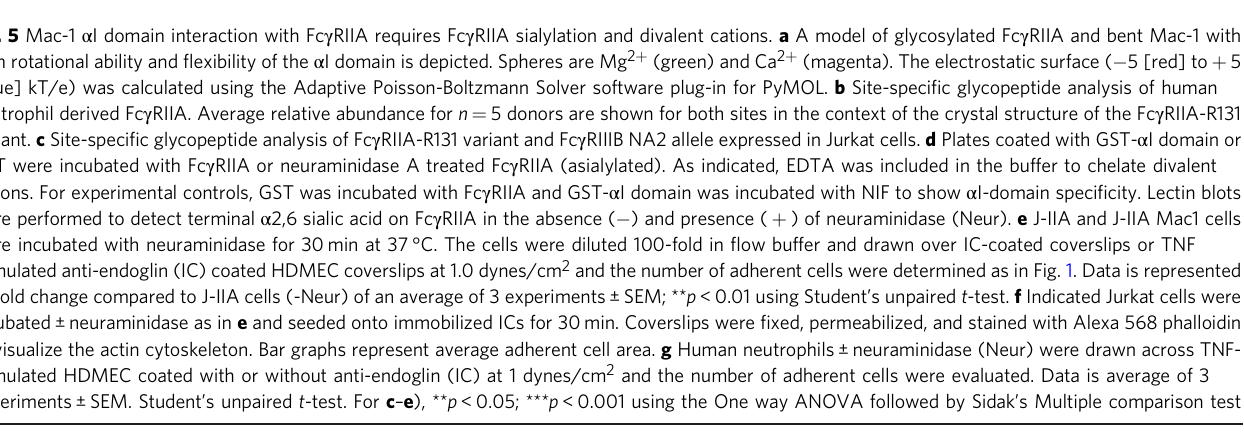
Fig. 5 Mac-1 α I domain interaction with Fc γ RIIA requires Fc γ RIIA sialylation and divalent cations. a A model of glycosylated Fc γ RIIA and bent Mac-1 with high rotational ability and fl exibility of the α I domain is depicted. Spheres are Mg 2 + (green) and Ca 2 + (magenta). The electrostatic surface ( − 5 [red] to + 5 [blue] kT/e) was calculated using the Adaptive Poisson-Boltzmann Solver software plug-in for PyMOL. b Site-speci fi c glycopeptide analysis of human neutrophil derived Fc γ RIIA. Average relative abundance for n = 5 donors are shown for both sites in the context of the crystal structure of the Fc γ RIIA-R131 variant. c Site-speci fi c glycopeptide analysis of Fc γ RIIA-R131 variant and Fc γ RIIIB NA2 allele expressed in Jurkat cells. d Plates coated with GST- α I domain or GST were incubated with Fc γ RIIA or neuraminidase A treated Fc γ RIIA (asialylated). As indicated, EDTA was included in the buffer to chelate divalent cations. For experimental controls, GST was incubated with Fc γ RIIA and GST- α I domain was incubated with NIF to show α I-domain speci fi city. Lectin blots were performed to detect terminal α 2,6 sialic acid on Fc γ RIIA in the absence ( − ) and presence ( + ) of neuraminidase (Neur). e J-IIA and J-IIA Mac1 cells were incubated with neuraminidase for 30 min at 37°C. The cells were diluted 100-fold in fl ow buffer and drawn over IC-coated coverslips or TNF stimulated anti-endoglin (IC) coated HDMEC coverslips at 1.0 dynes/cm 2 and the number of adherent cells were determined as in Fig. 1. Data is represented as fold change compared to J-IIA cells (-Neur) of an average of 3 experiments± SEM; ** p < 0.01 using Student ’ s unpaired t -test. f Indicated Jurkat cells were incubated±neuraminidase as in e and seeded onto immobilized ICs for 30min. Coverslips were fi xed, permeabilized, and stained with Alexa 568 phalloidin to visualize the actin cytoskeleton. Bar graphs represent average adherent cell area. g Human neutrophils± neuraminidase (Neur) were drawn across TNF- stimulated HDMEC coated with or without anti-endoglin (IC) at 1 dynes/cm 2 and the number of adherent cells were evaluated. Data is average of 3